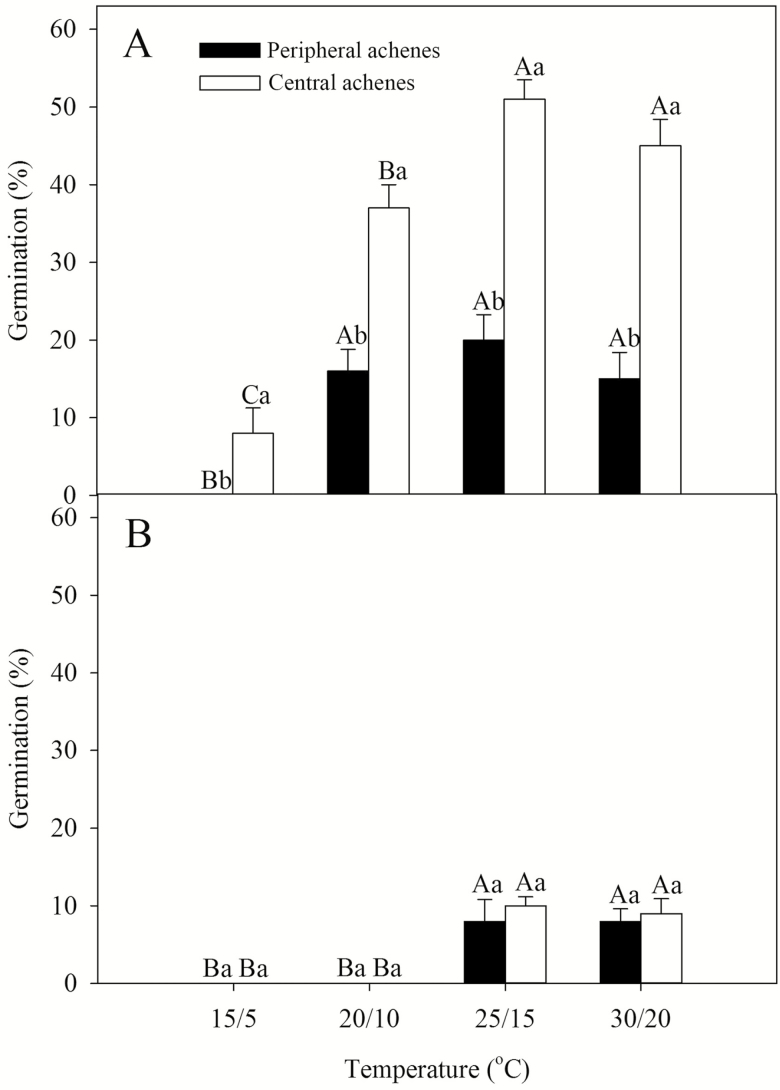
Effect of light and temperature on germination percentage (mean ± SE) of freshly matured dimorphic achenes of Bidens pilosa. (A) Germinated in light; (B) germinated in dark. The letters indicating significance are based on Tukey’s HSD after ANOVA. For each light treatment, different uppercase and lowercase letters indicate significant differences between treatments at different temperatures within each achene morph and between shout and central achenes within each temperature, respectively (5 % level).